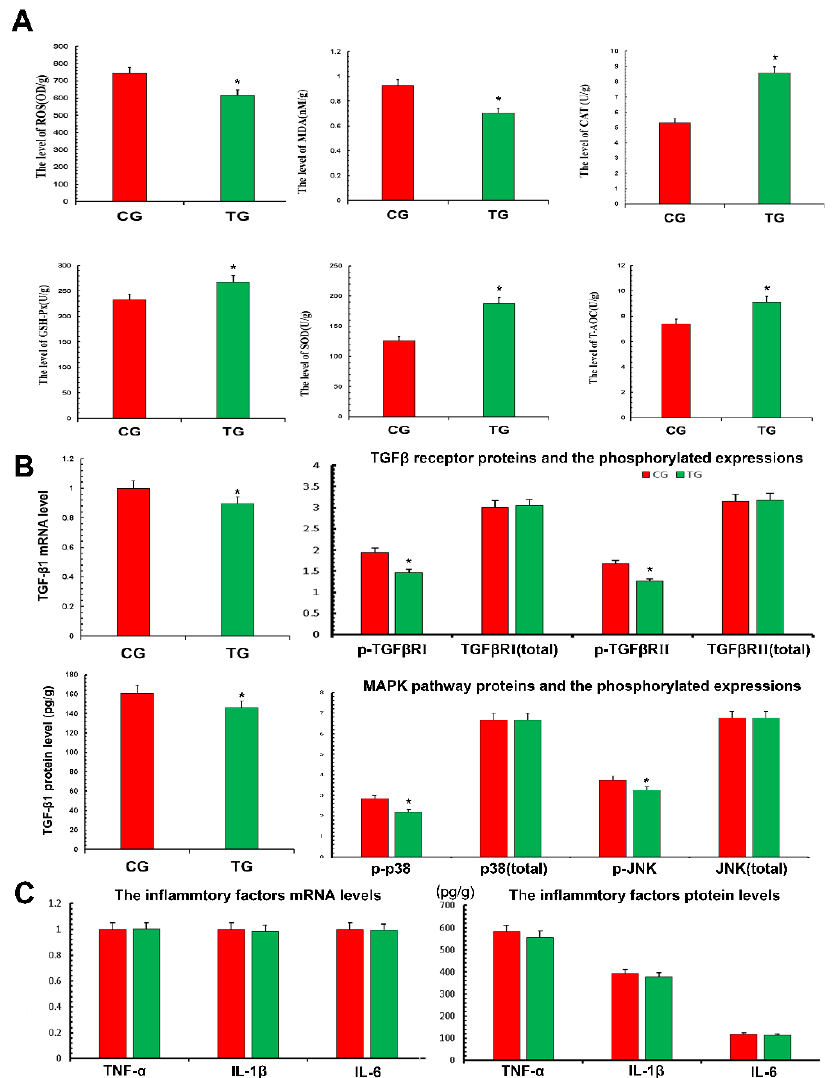
Figure 4. Antioxidant capacity and inflammatory factors expressed in the mammary gland. Proteins expressions were detected with ELISA kits. RT-qPCR was used to verify mRNA expression. GAPDH was used as a control. ( A ) The measurement of oxidative damage and antioxidant capacity. ( B ) The detection of TGF- β -associated inflammatory signaling pathway. ( C ) The proteins expressions of TNF- α , IL-1 β and IL-6. CG, control group, milk duct perfusion with 6 mg/kg normal saline. TG, tea polyphenols group, milk duct perfusion 6 mg/kg tea polyphenols. The asterisk represents the comparison with CG, and p < 0.05 is significantly different from CG. The experimental data represent the mean ± SD of three independent experiments.